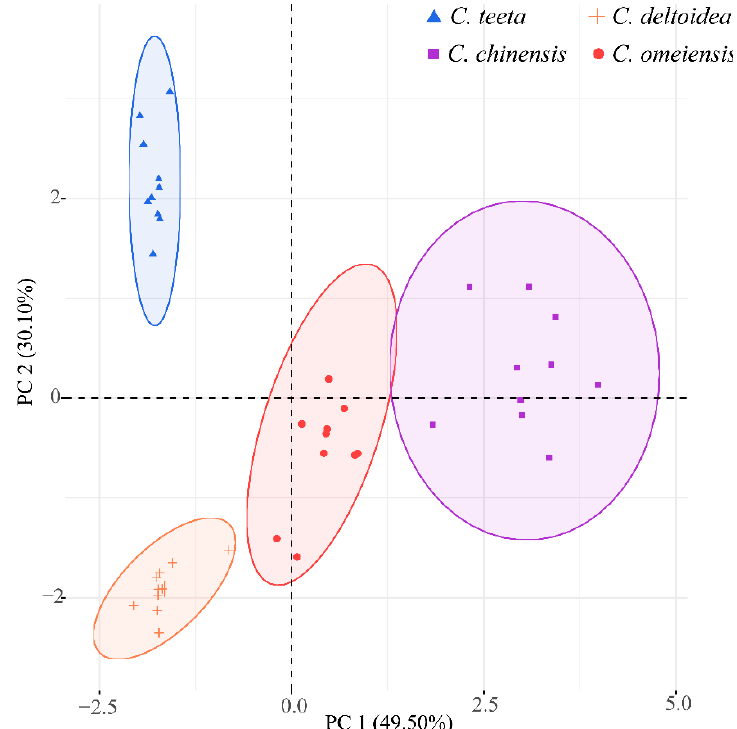
Figure 2. PCA score plot of different Coptis medicines based on quantitative determination of alkaloid compounds.